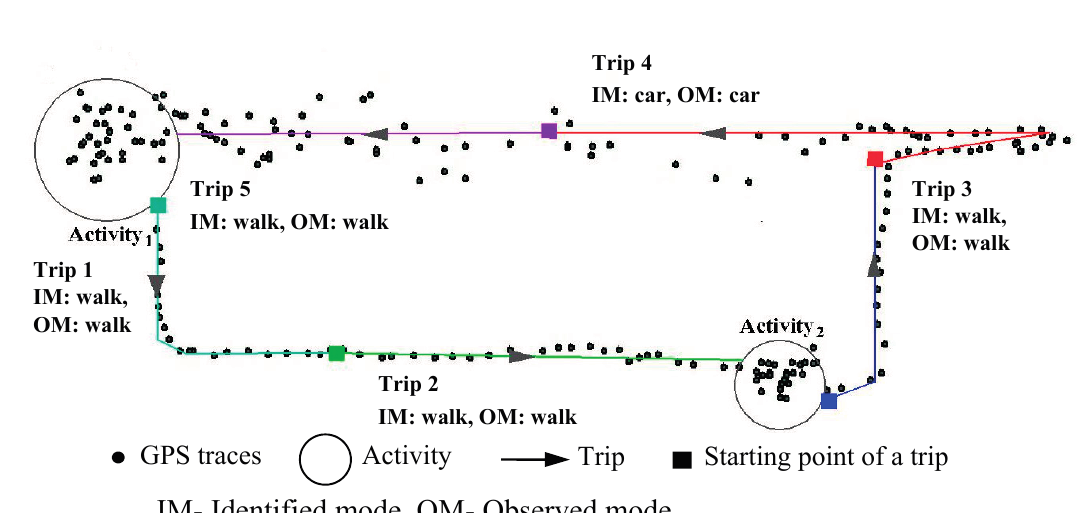
Figure 4. Identified and observed mode choices of respondent